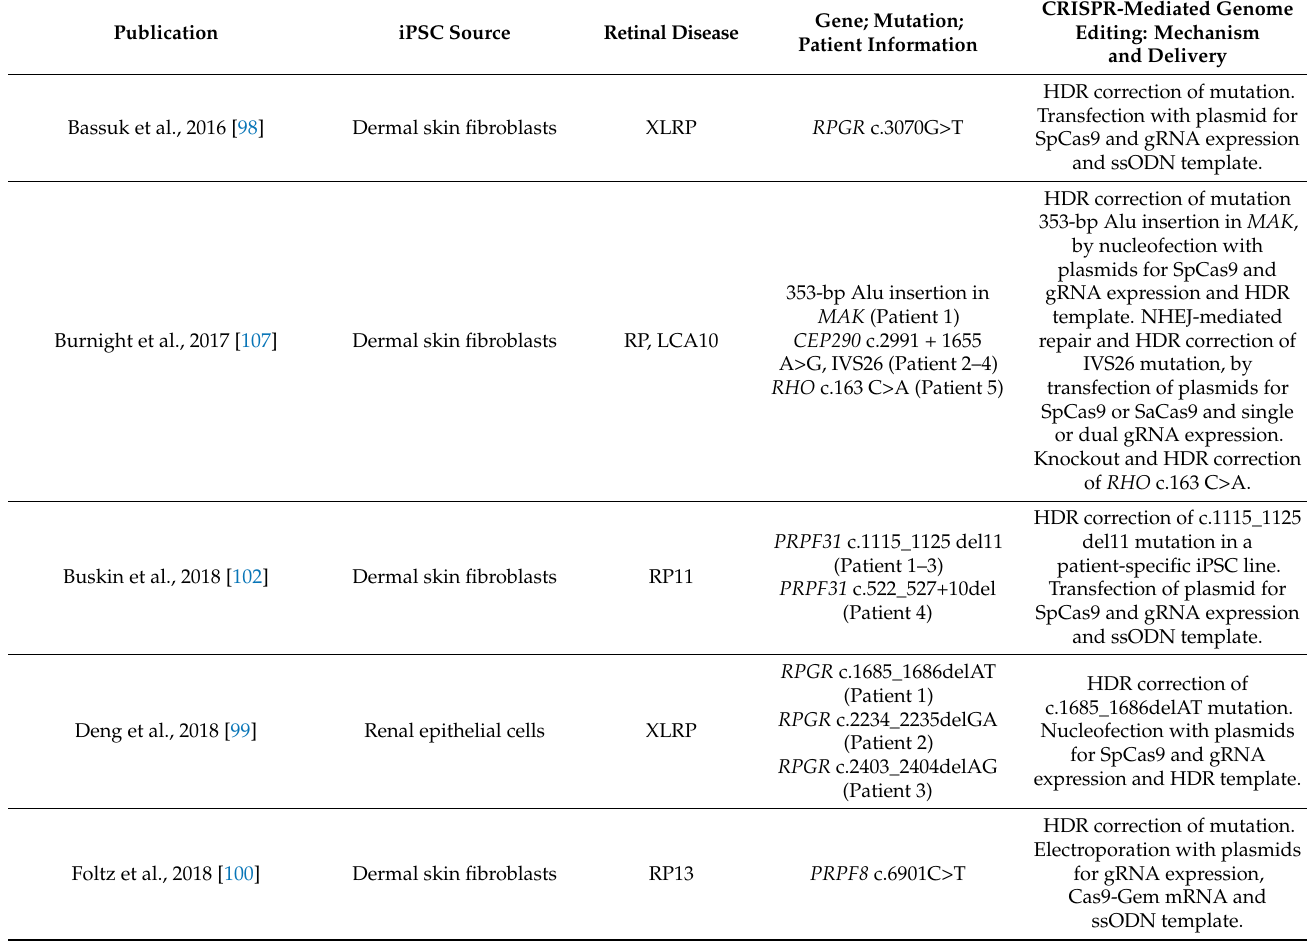
Table 2. Applications of CRISPR/Cas9 technologies combined with iPSCs in the study and treatment of retinal degenerative